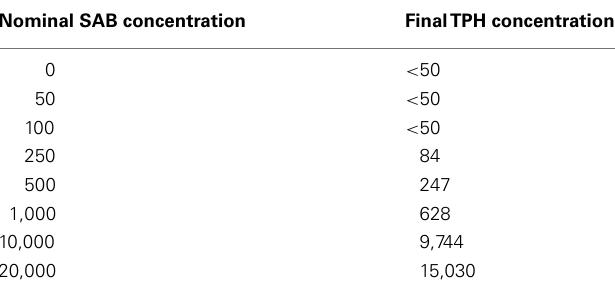
Table 1 |Total petroleum hydrocarbon concentrations in spiked soil samples (mg kg − 1